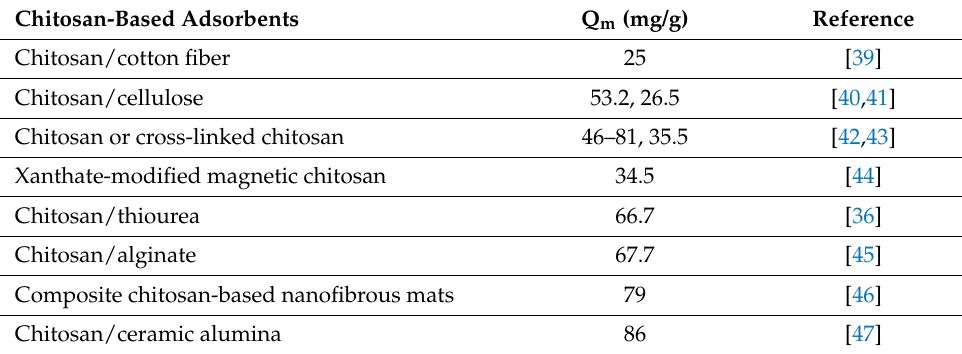
Table 3. Comparison of the maximum adsorption capacity based on Langmuir model of this study with other chitosan-based adsorbents.